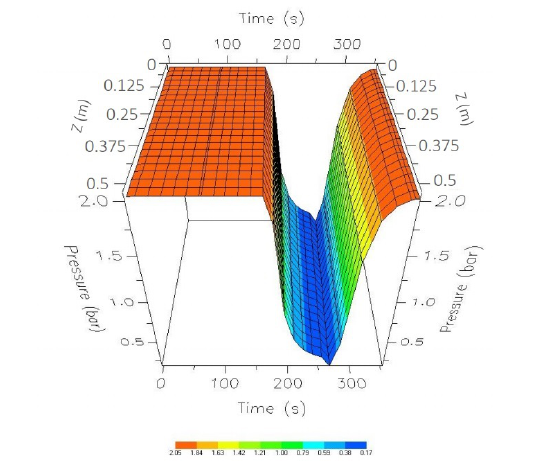
Figure 11. One-cycle pressure profile while in